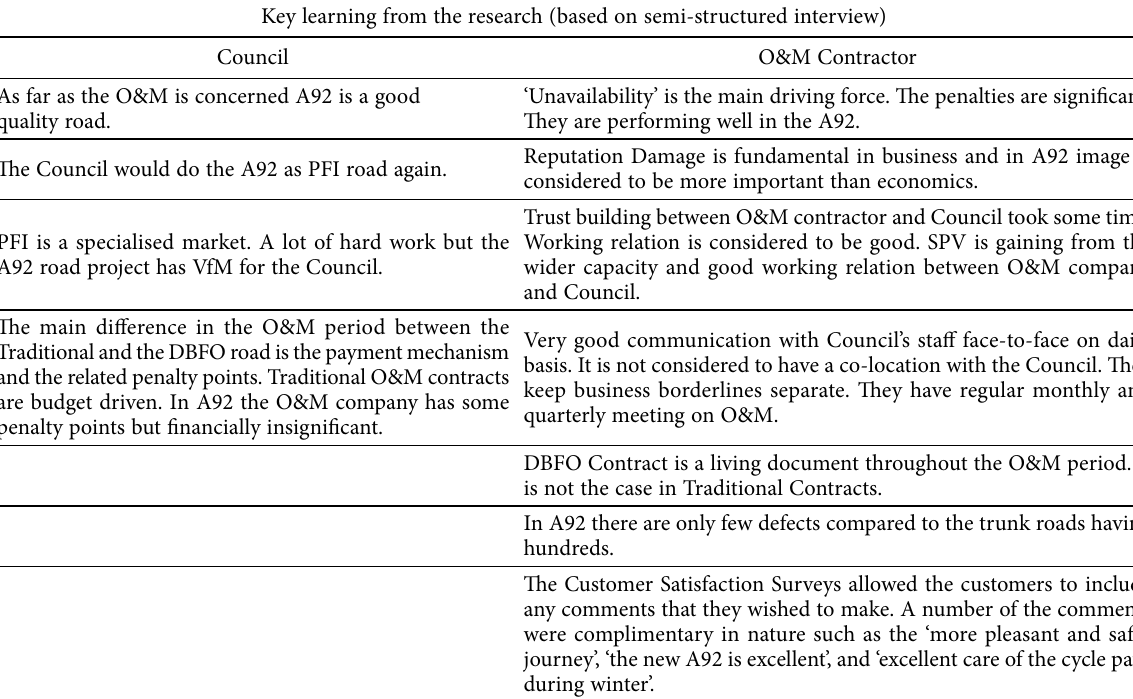
Table 9. Key learning from A92 O&M